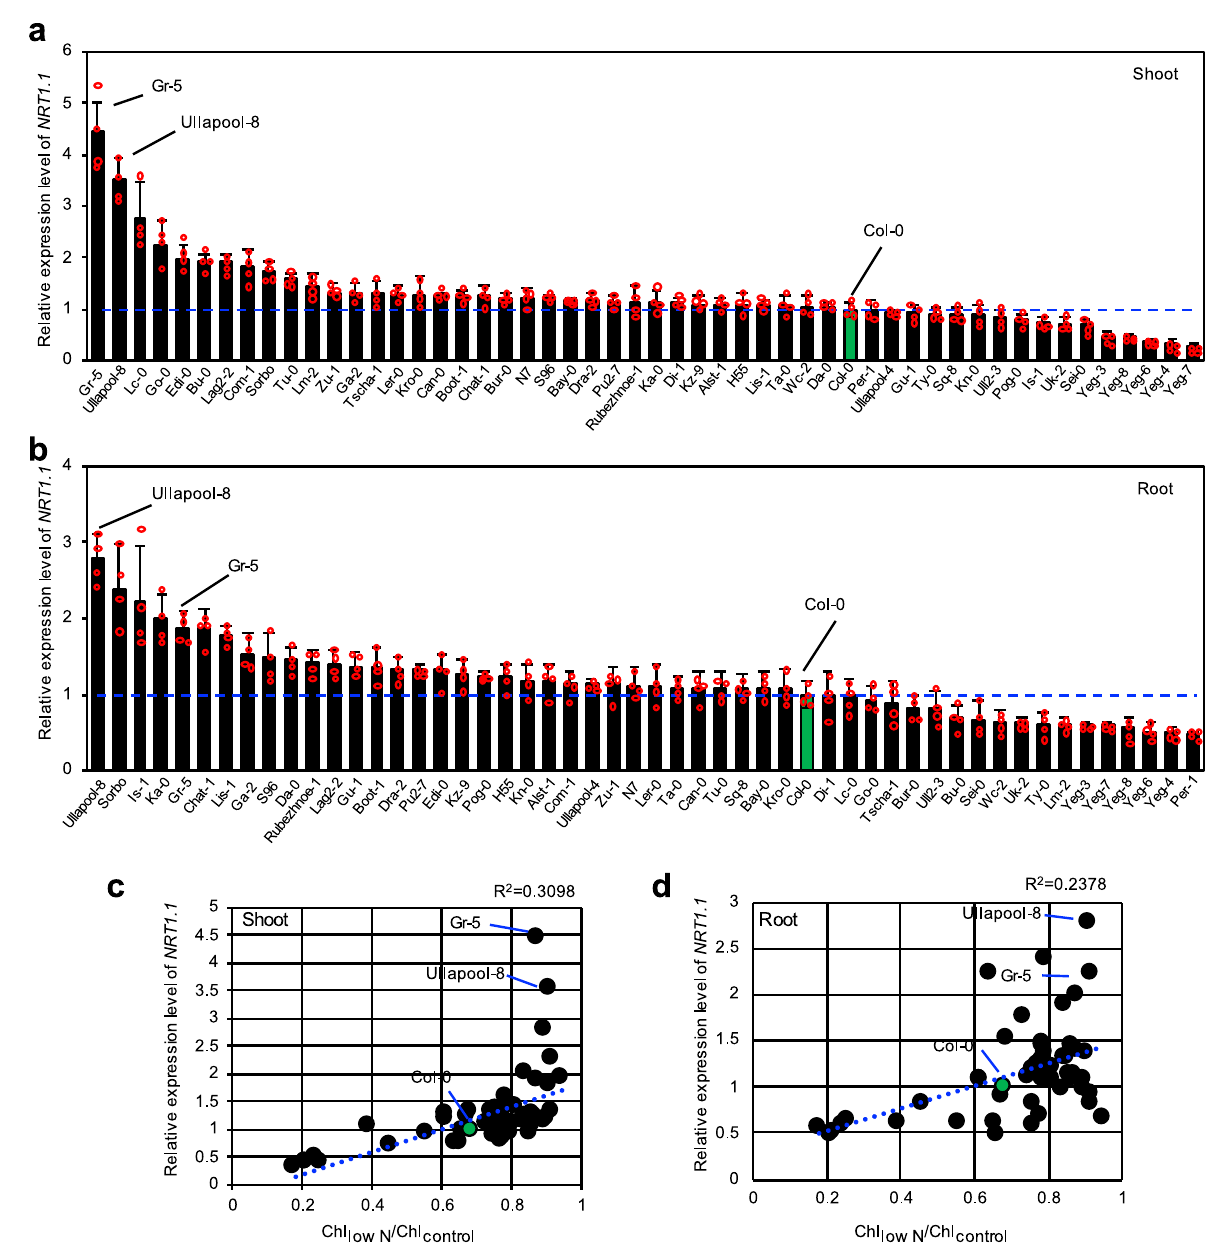
Fig. 2 Correlation between expression levels of NRT1.1 and N de fi ciency-induced reduction in chlorophyll content. a , b Expression levels of NRT1.1 in the shoots ( a ) and roots ( b ) of 2-week-old seedlings of 52 Arabidopsis accessions grown on 1/2 MS agar plates under continuous light condition. Transcript levels of NRT1.1 were normalized relative to those of ACTIN2 ( ACT2 ). Relative expression levels of NRT1.1 in Col-0 (indicated by green bars and blue dotted lines) were set to 1. Data represent mean ± standard deviation (SD) of four biological replicates. c , d Correlation analysis of NRT1.1 expression levels in shoots ( c ) and roots ( d ) with Chl low N /Chl control